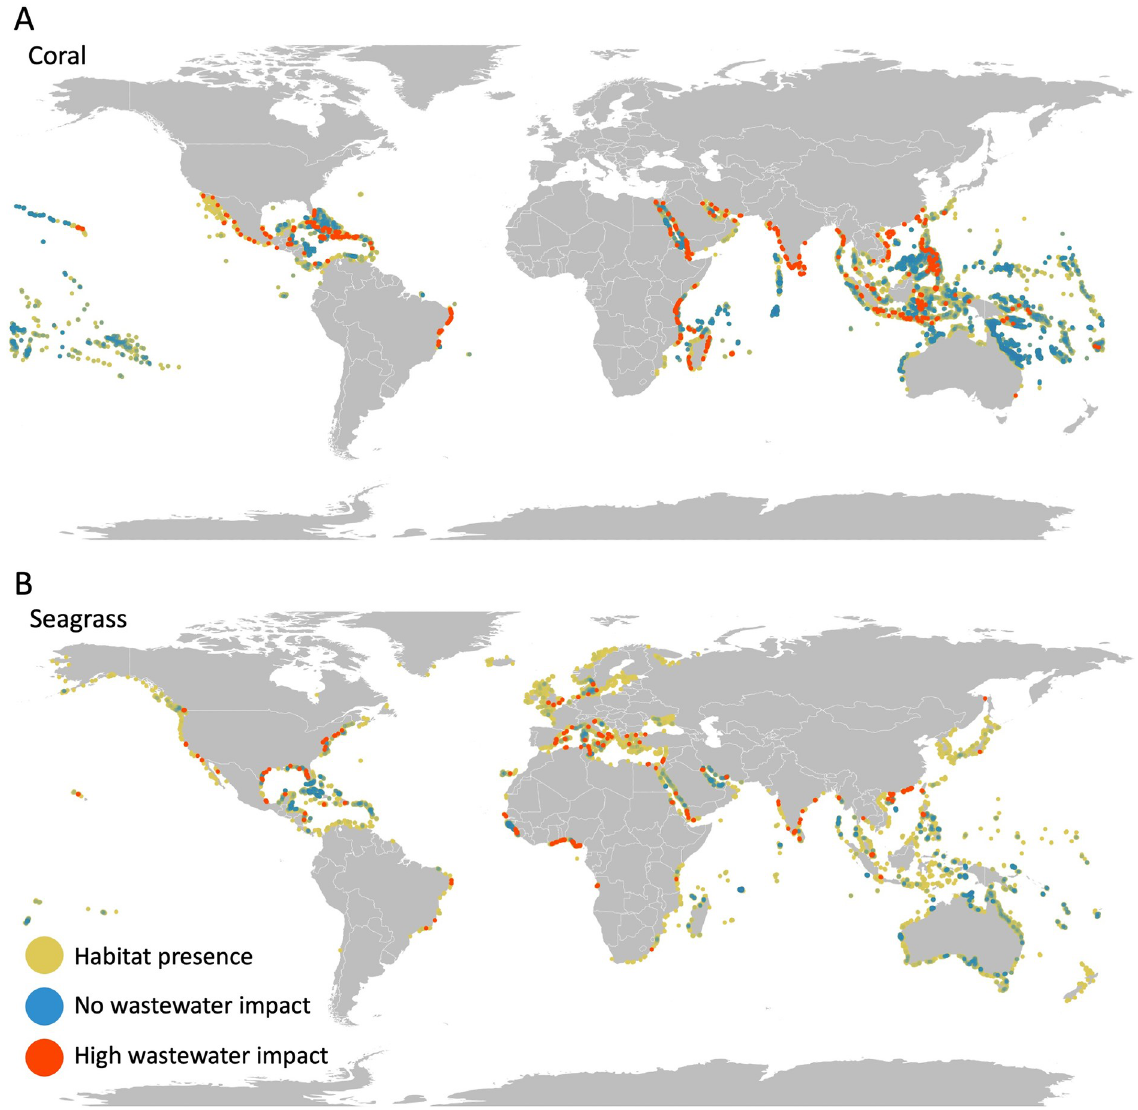
Fig 3. Expected impact of N on sensitive coastal habitats. Maps show where A) coral reefs and B) seagrass beds are heavily impacted (raster cells in top 2.5% of exposure; red dots), not impacted (no exposure to wastewater N; dark blue dots), or impacted but not in the top 2.5% (yellow dots). Raster cells are represented as points which visually over-represents the habitat; red is overlaid on top which makes it visually dominant; blue points are transparent and overlaid on green/yellow points such that higher densities of unimpacted areas are brighter